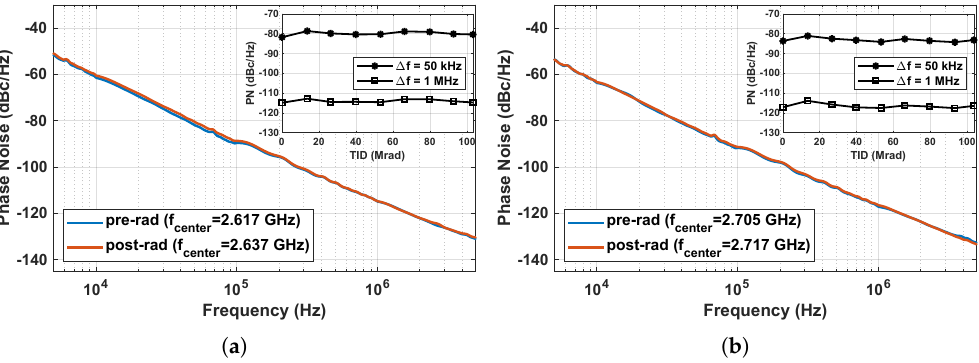
Figure 11. Phase noise measured at f center before (pre-rad) and after (post-rad) radiation exposure of the order of 100 Mrad (SiO 2 ) from the outputs of the ( a ) PQVCO and ( b ) SQVCO. Table 1 presents a performance comparison of the implemented QVCOs with respect to previously reported VCOs [28,29,46,47] and QVCOs [33] which are studied under radiation (TID) exposure. Similar to [28], the implemented QVCOs in this work are targeted to operate in the s-band. The implemented QVCOs consume double power in comparison with [28] as two oscillator cores are coupled together to generate quadrature phases. Based on open loop phase noise characteristics, the implemented QVCOs achieve more than 3 dB better phase noise at 1 MHz offset. However, [28] has a similar rate of variations of the frequency with respect to TID level when compared to the implemented QVCOs. The oscillator in [47] has combined small varactors with large digitally switchable capacitor- banks (64 units) and therefore could achieve better phase noise performance compared to the other reported designs. Prior to this work as published in the literature to date, ref. [33] has been the sole instance of TID study performed on QVCOs. Therefore, the results are included in the comparison, even though it is implemented using a 32 nm CMOS SOI technology which is different from the one used in this work. Although TID induced variations tend to reduce with smaller feature sizes, the QVCOs reported in [33] show more frequency variation and less TID tolerance compared to the QVCOs implemented in this